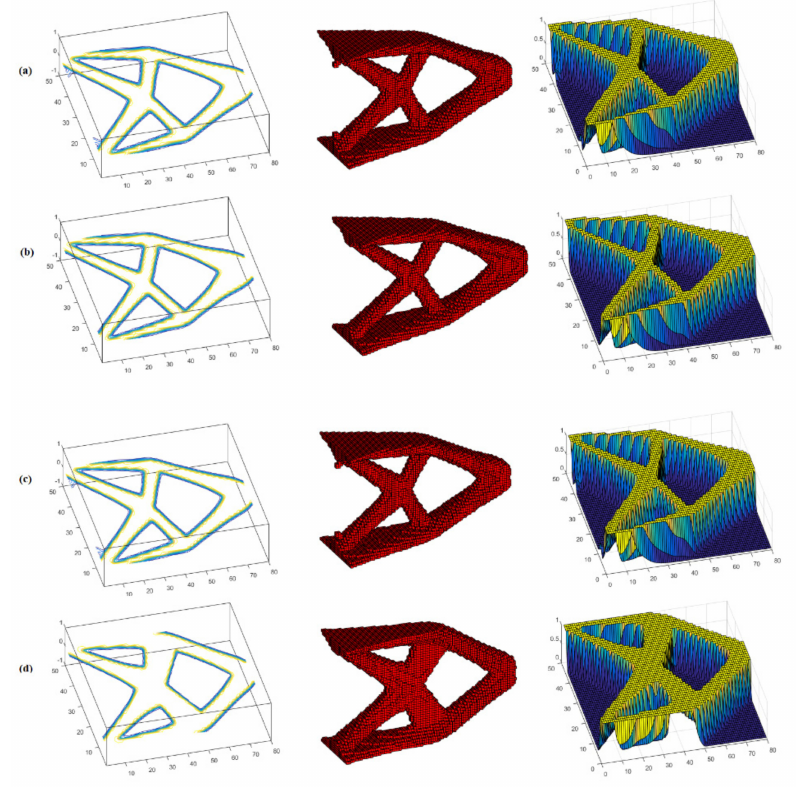
Figure 5. DTO: contour, topology and surface: ( a ) ESO, ( b ) SERA, ( c ) SESO and ( d ) SIMP.